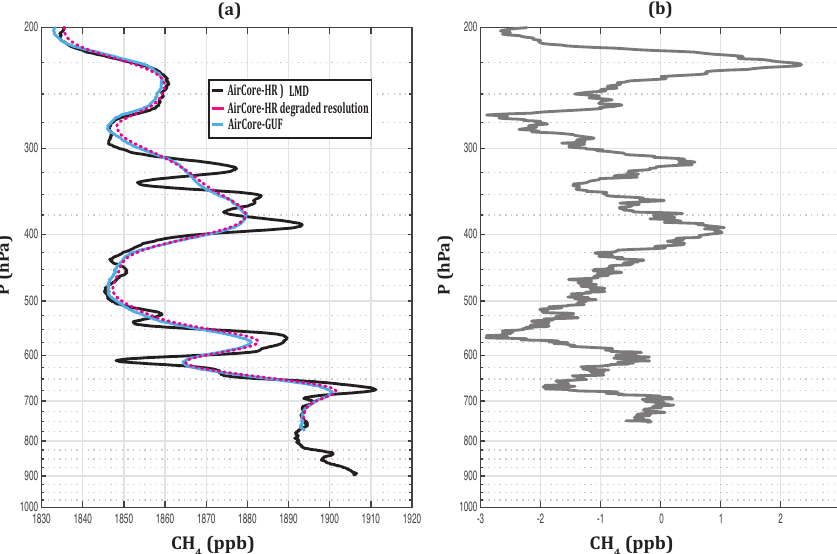
Figure 14. (a) CH 4 vertical profiles from AirCore-HR in full resolution (black), from AirCore-HR in “degraded resolution” (pink) and from AirCore-GUF (blue). (b) Residual of the difference AirCore-GUF − AirCore-HR in “degraded